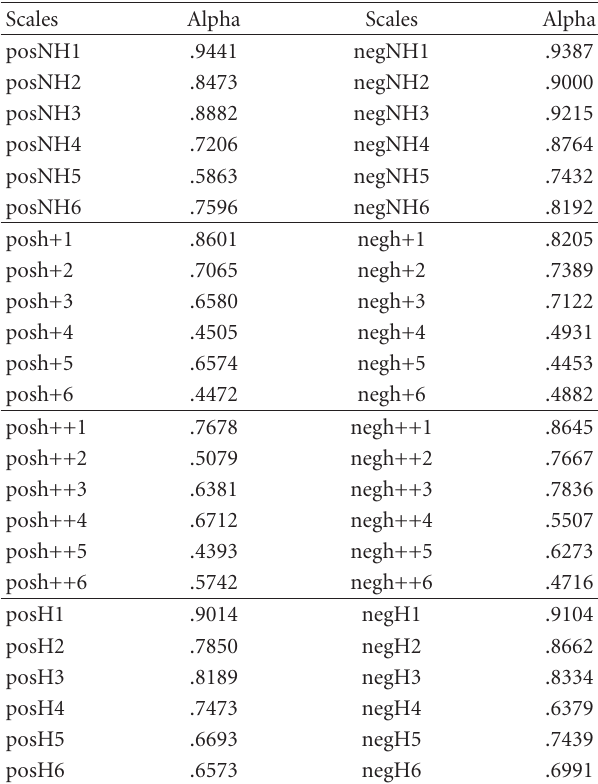
Table 2: Cronbach’s alpha of the QDF subscales “positive” and “negative” (legend, see Table